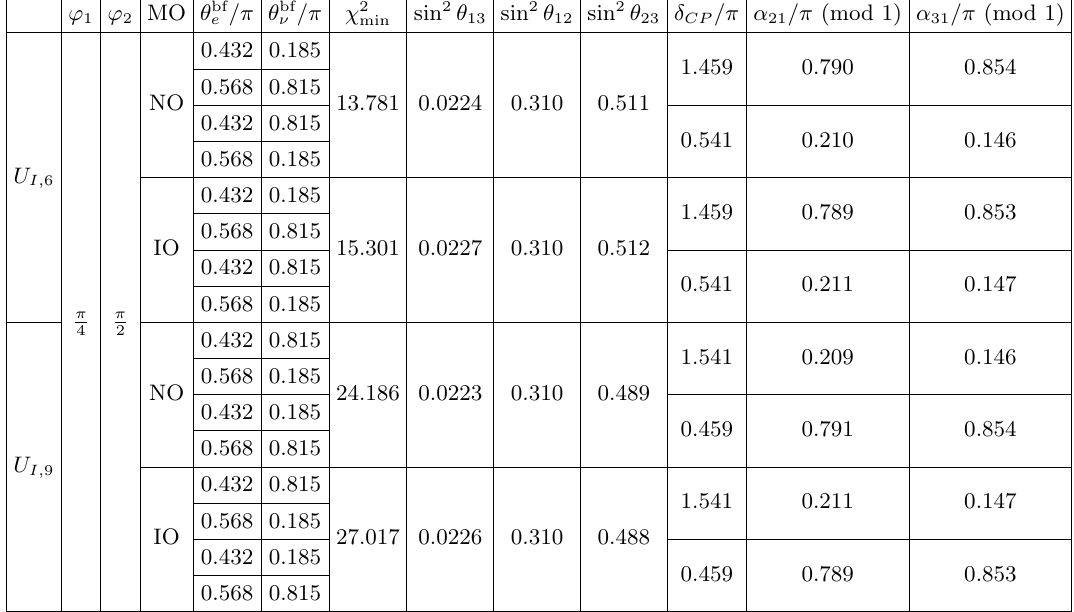
Table 3 . Results of the (cid:31) 2 analysis for the phenomenologically viable mixing patterns U I; 6 and U I; 9 with ’ 1 = (cid:25)= 4 and ’ 2 = (cid:25)= 2 which can be achieved from the D 4 (cid:13)avor group. Since the global (cid:12)t results of the mixing angles slightly di(cid:11)er for normal ordering (NO) and inverted ordering (IO) neutrino mass spectrums, we consider these two cases separately. The (cid:31) 2 function reaches a global minimum (cid:31) 2 at the best (cid:12)t values ( (cid:18) e ; (cid:18) (cid:23) ) = ( (cid:18) bf ; (cid:18) bf ). We display the values of the mixing angles e (cid:23) min and CP violation phases at the best (cid:12)tting